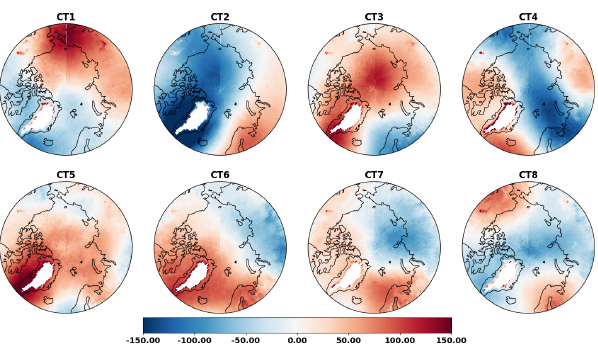
Figure 4. Geopotential height anomalies (m) at 500hPa based on AIRS data for the eight circulation types.